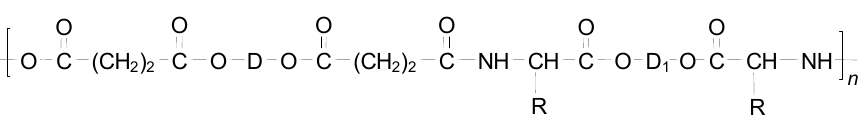
Figure 25. AABBP composed of alkylene